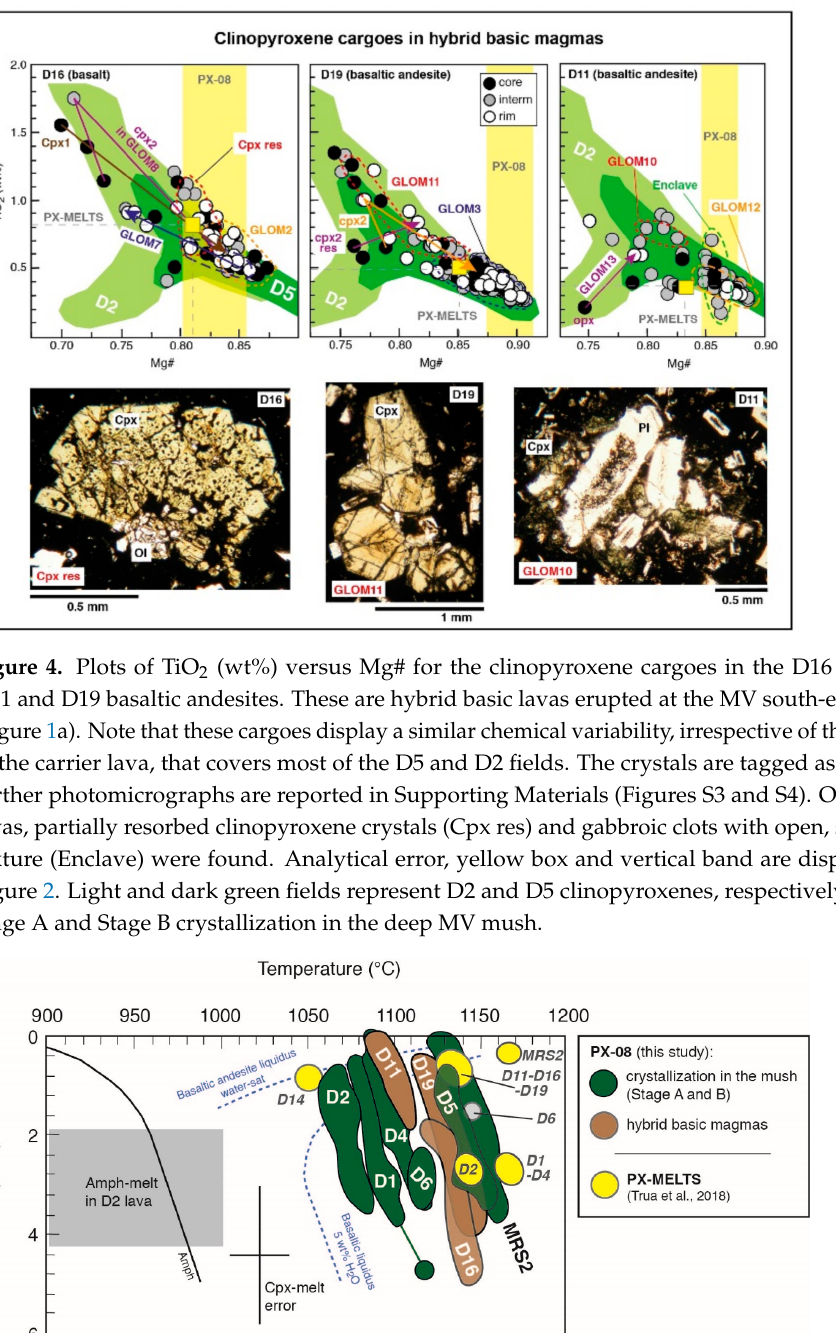
Figure 5. Results of the PX-08 calculations. The coloured fields represent the sets of calculated pressure-temperature for clinopyroxene-melt pairs in the studied lavas that passed the PX-08 tests (see Figure S5 in Supplementary Materials); the colour-code is the same as in Figure 1. For comparison, the PX-MELTS-derived values (yellow circles) are shown [18]. The clinopyroxene-melt pairs in basalts and basaltic andesites from the MV central portion (green fields) illustrate the P-T conditions for Stage A and Stage B crystallization in the mush; those in basalts and basaltic andesites from the south-eastern flank of the MV (brown fields) illustrate the P-T conditions for hybrid basic magmas. The P-T field obtained from D2 amphibole thermobarometric calculations [22] is also reported in the grey box. The liquidus (liquid to the right of each line) for basalt with 5 wt% H 2 O and water-saturated basaltic andesite (blue dotted lines) and the amphibole-in boundary line in black (amphibole to the left of the line) are from